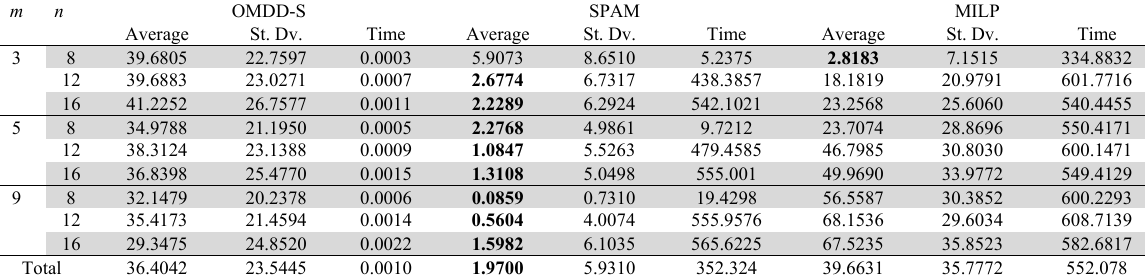
Small-sized test instances: RDI values for m and n (part 2) m